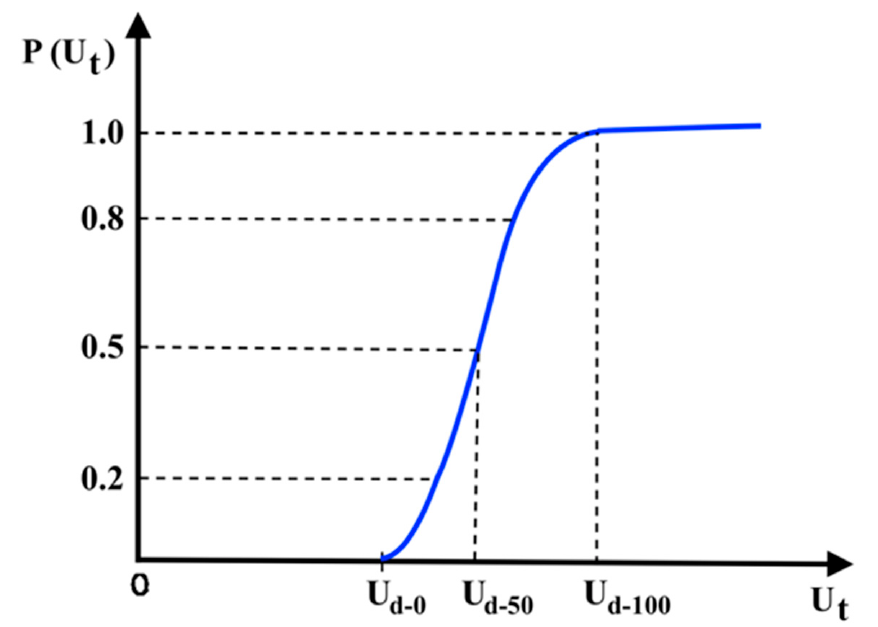
Figure 12. Cumulative distribution function of breakdown values.